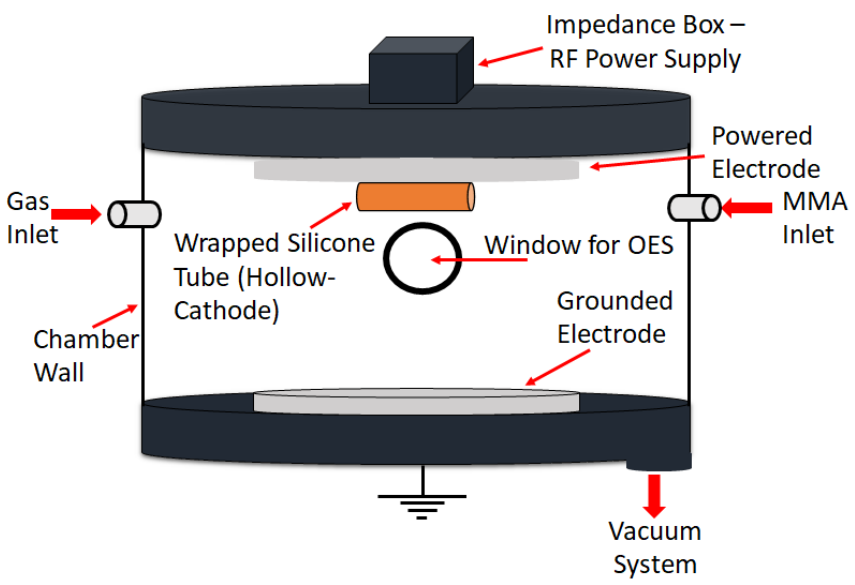
Figure 2. Schematic presentation of the capacitively coupled RF plasma reactor for plasma polymerization. Table 1. Process parameters (Working pressure: 0.4 torr) .